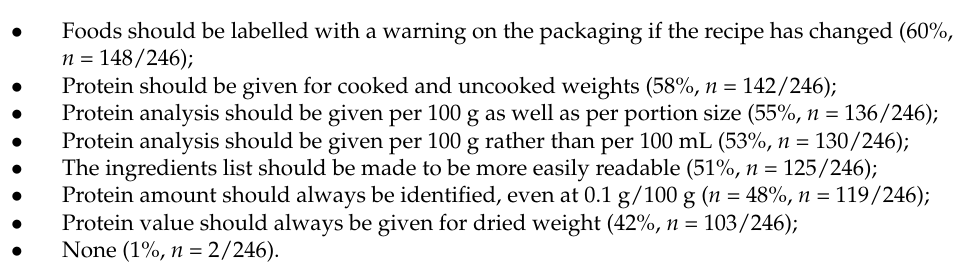
Table 5. Suggested changes to protein labelling as requested by questionnaire respondents (respon- dents could choose more than one response), n =